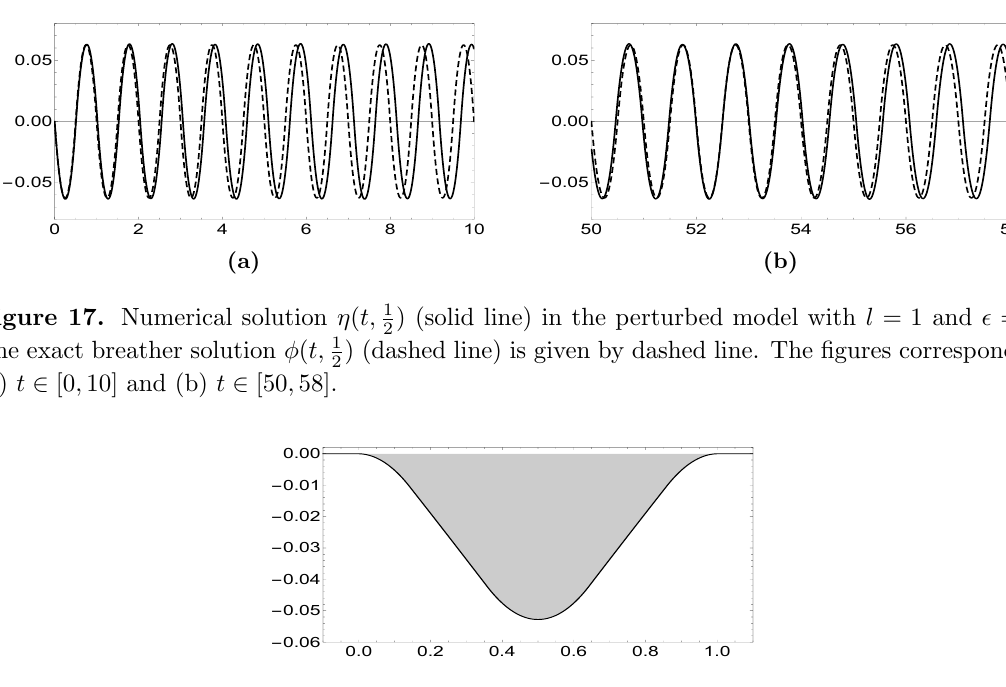
Figure 18. The numerical solution (cid:17) ( t; x ) in the perturbed model with l = 1 and (cid:15) = 1 at t = 10 : 344 + 0 : 15 = 10 (cid:2) period + 0 : 15. The solution is very similar to the solution shown in (cid:12)gure